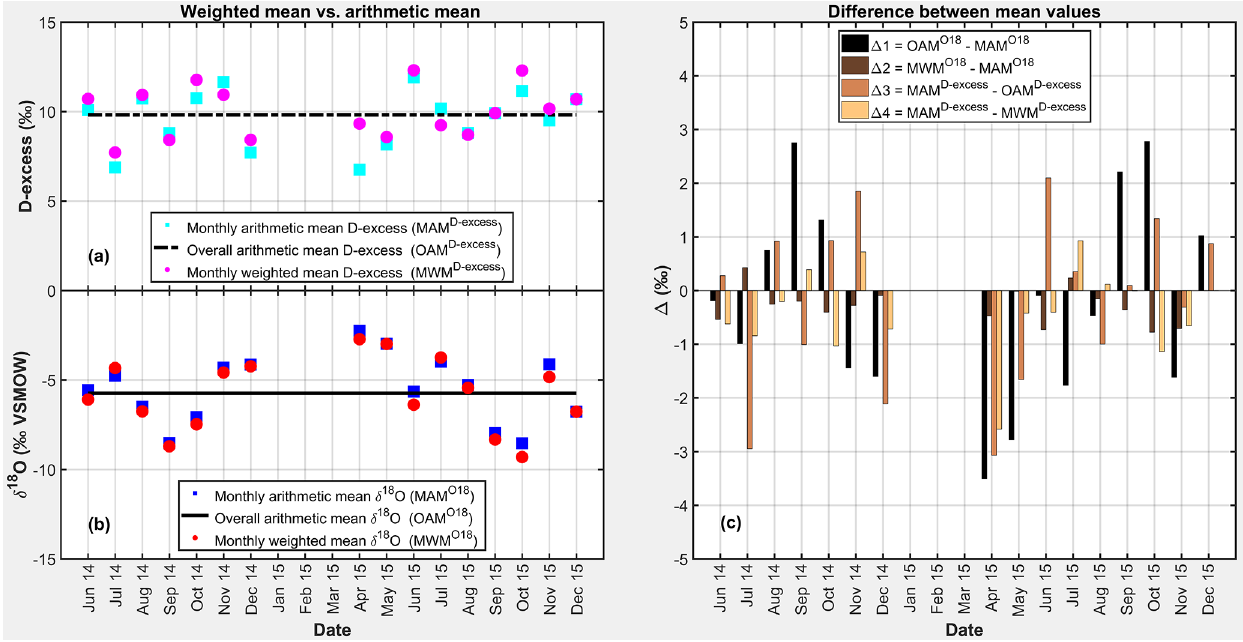
Figure 10. Monthly arithmetic mean (MAM) vs. overall arithmetic mean (OAM), and MAM vs. monthly amount-weighted mean (MWM) for d-excess (a) and δ 18 O (b) at An Long during the sampling period June 2014 to December 2015. The difference between these mean values (c) including (cid:49) 1 = OAM 18 O − MAM 18 O , (cid:49) 2 = MWM 18 O − MAM 18 O for δ 18 O, and (cid:49) 3 = MAM D − excess − OAM D − excess , (cid:49) 4 = MAM D − excess − MWM D − excess for d-excess are shown to examine in which month secondary fractionation processes are likely significant (defined by all values of (cid:49) in that month smaller than